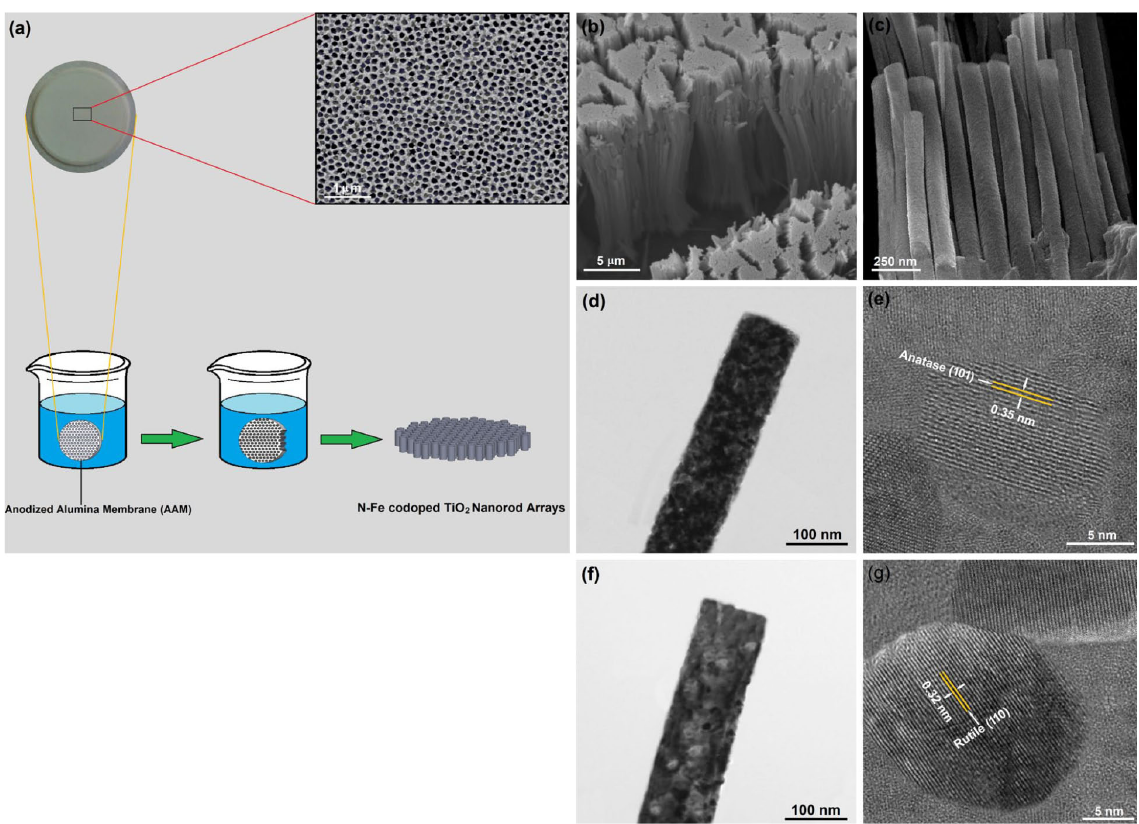
Fig. 1 (a) Schematic illustration for the formation of N–Fe codoped TiO 2 nanorod arrays via template-directed LPD (inset presents surface-view FESEM image of AAM template). (b, c) Typical low and high magnification FESEM images of the N–Fe codoped TiO 2 nanorod arrays. (d, e) TEM and HRTEM images of the individual N–Fe codoped nanorod annealed at 600 ℃